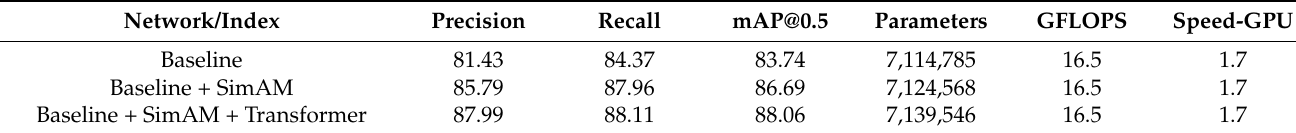
Table 3. Ablation experimental